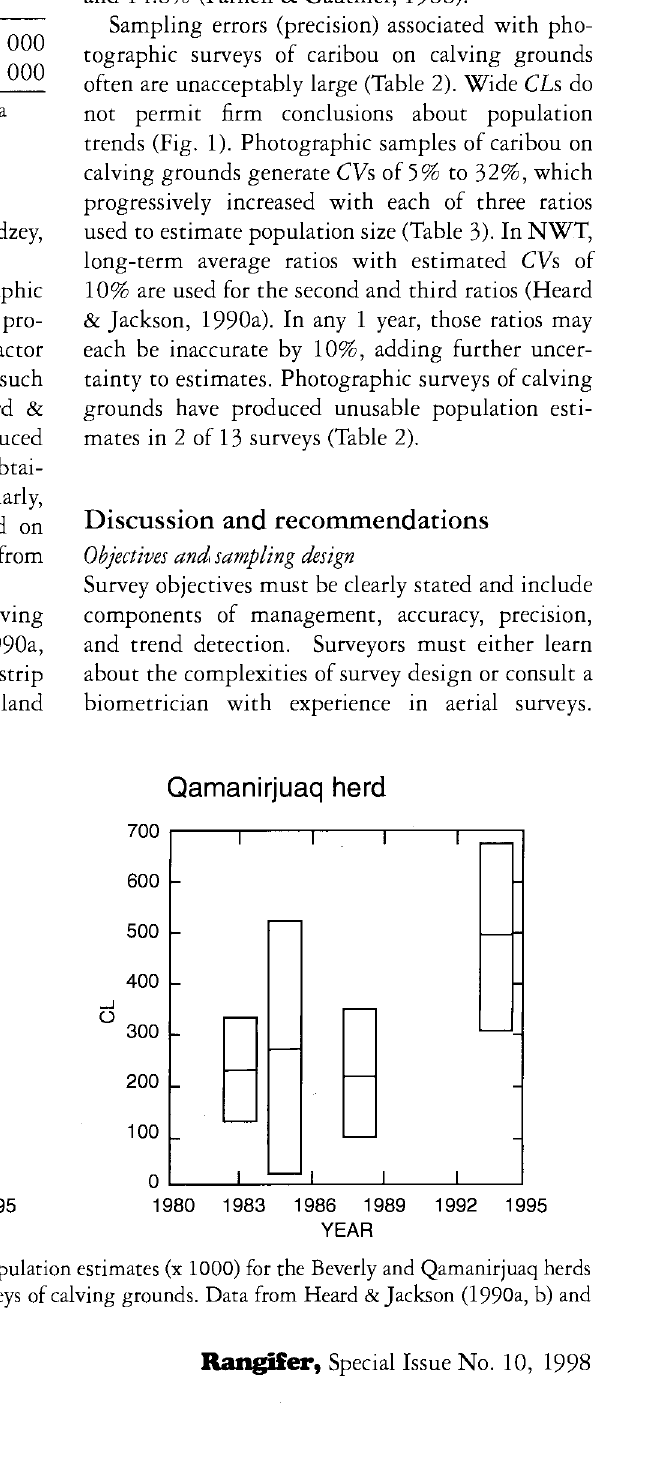
Fig. 1. Estimated 90% confidence limits of (CL) population estimates (x 1000) for the Beverly and Qamanirjuaq herds derived from 1982-1994 photographic surveys of calving grounds. Data from Heard & Jackson (1990a, b) and Gunn (this